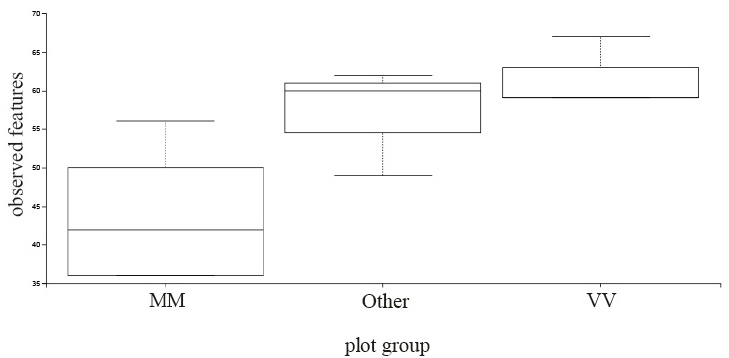
Figure 7. α -diversity box-plot considering OTU number in parcels from Monção and Melgaço re- gion (MM), Vinho Verde region (VV) and all the rest parcels analyzed (Other) . (MM), Vinho Verde region (VV) and all the rest parcels analyzed (Other).